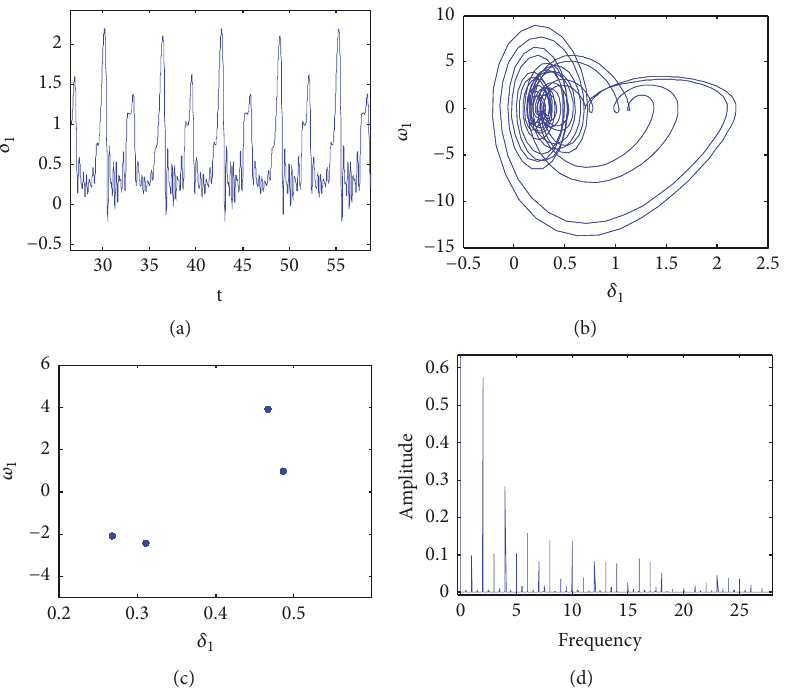
Figure 12: Period 4 motion ( D =0.0085). (a) Time history. (b) Phase portrait. (c) Poincar´e map. (d) Frequency spectrum.